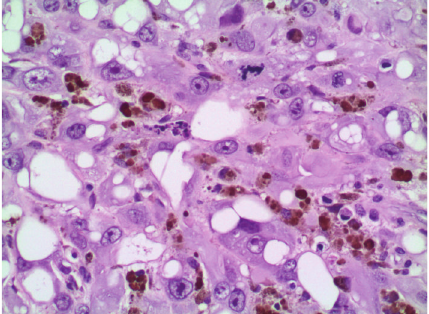
Figure 2: An area indistinguishable from cavernous hemangioma with large blood-filled spaces lined by flattened bland endothelium.